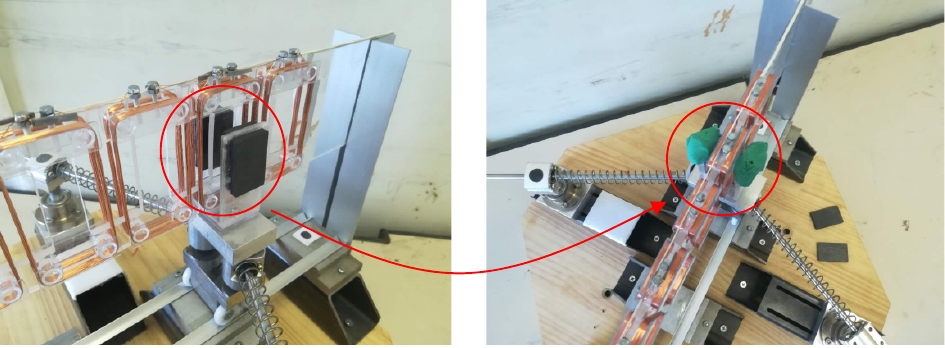
Figure 25. Displacement measurement with and without magnet.